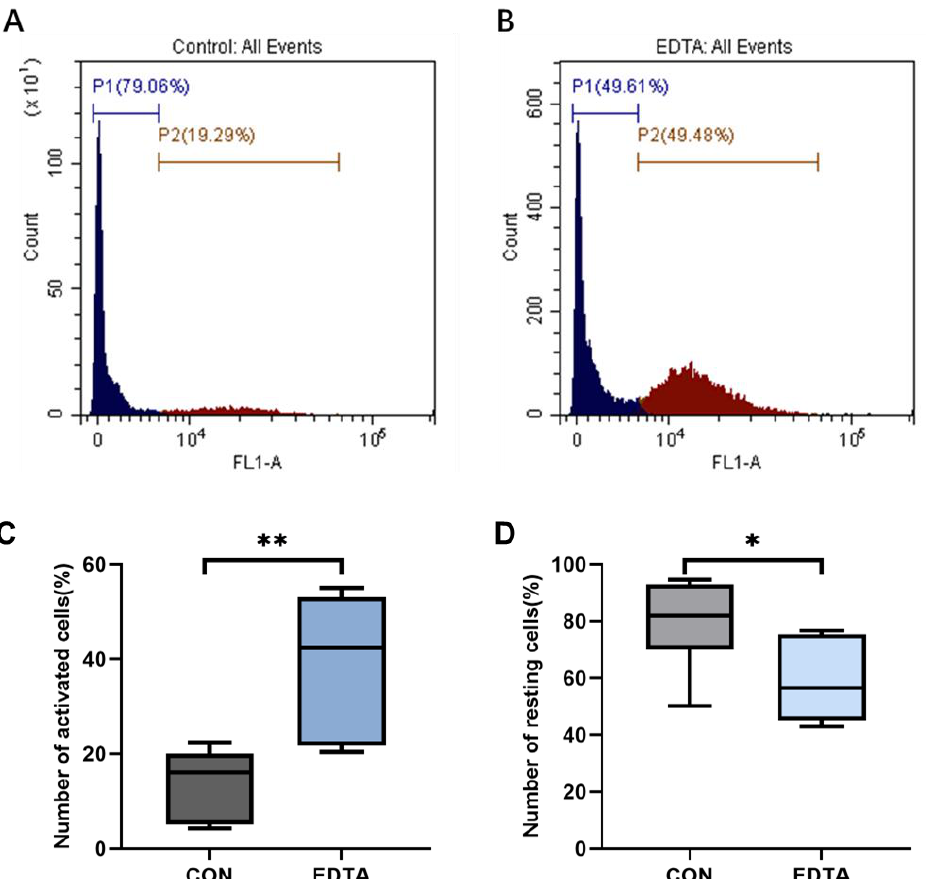
Figure 2. Flow cytometry of the neutrophil respiratory burst. ( A ) Flow cytometry spectrum of neutrophils in the control group. ( B ) Flow cytometry spectrum of neutrophils in the EDTA group. ( C ) The percentage of activated cells in the control and EDTA groups. ( D ) The percentage of stationary cells in the control and EDTA groups. CON: control group, EDTA: experimental group. Statistically significant differences are indicated by * p < 0.05, ** p < 0.01.